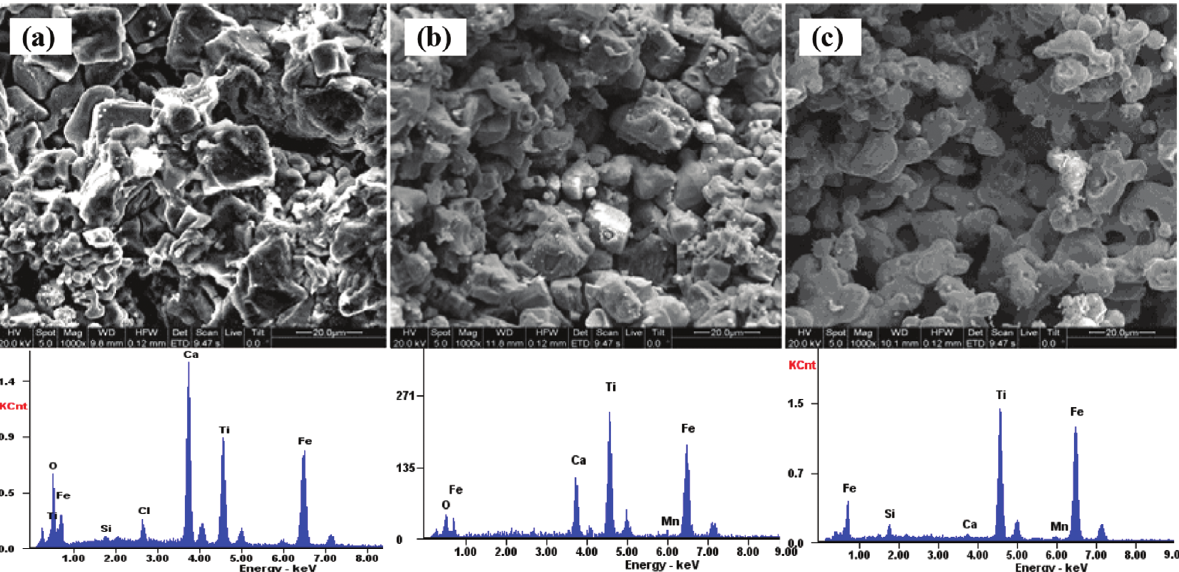
Figure 2: SEM images and EDX spectra of the Fe – Ti residue pellets after electrolysis for different times: (a) 2 h, (b) 4 h and (c) 6 h.